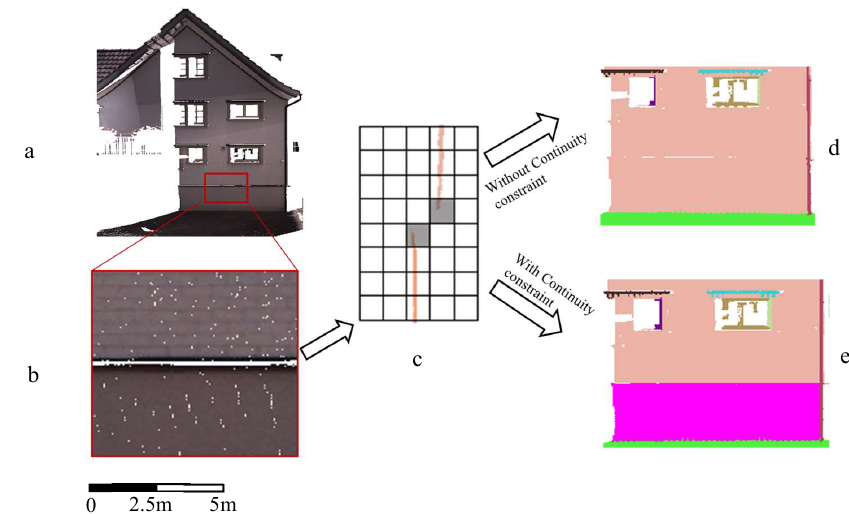
Figure 17. Managing a parallel plane. ( a ) Original point cloud of terrestrial laser scanner data, and ( b ) two parallel planes that are close to each other, ( c ) side view of ( b ) and the result of voxelization, ( d ) segmentation result of ( b ) without continuity constraint, and ( e ) segmentation result of ( b ) with continuity constraint.